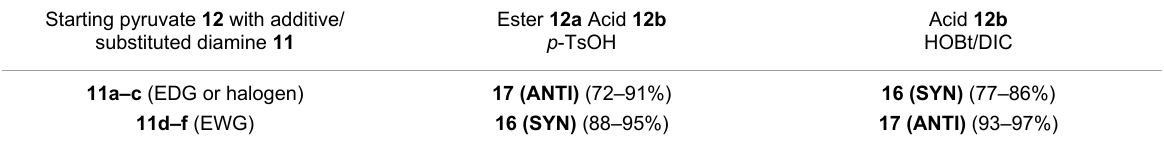
Table 2: The guide for reaction conditions for obtaining the desired regioisomer of 3,4-dihydroquinoxaline-2(1 H )one 16 (SYN) or 17 (ANTI) with the best